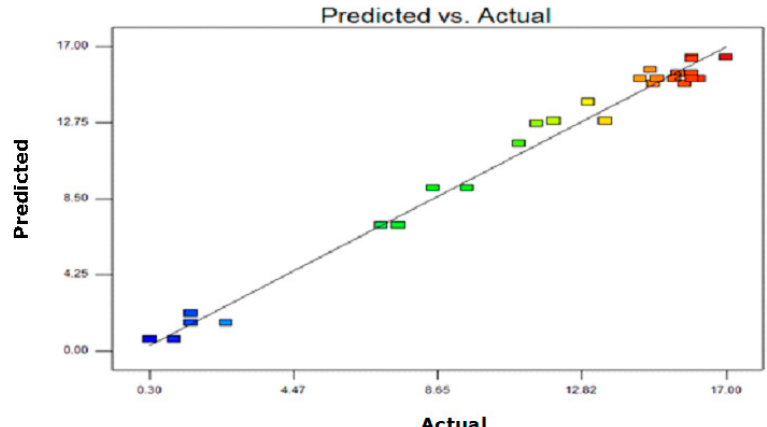
Figure 2. Scatter plot of predicted value versus actual value, from the central composite design for yield of A. malaccensis wood essential oil. Table 3. ANOVA and regression coefficient for the reduced quadratic model.